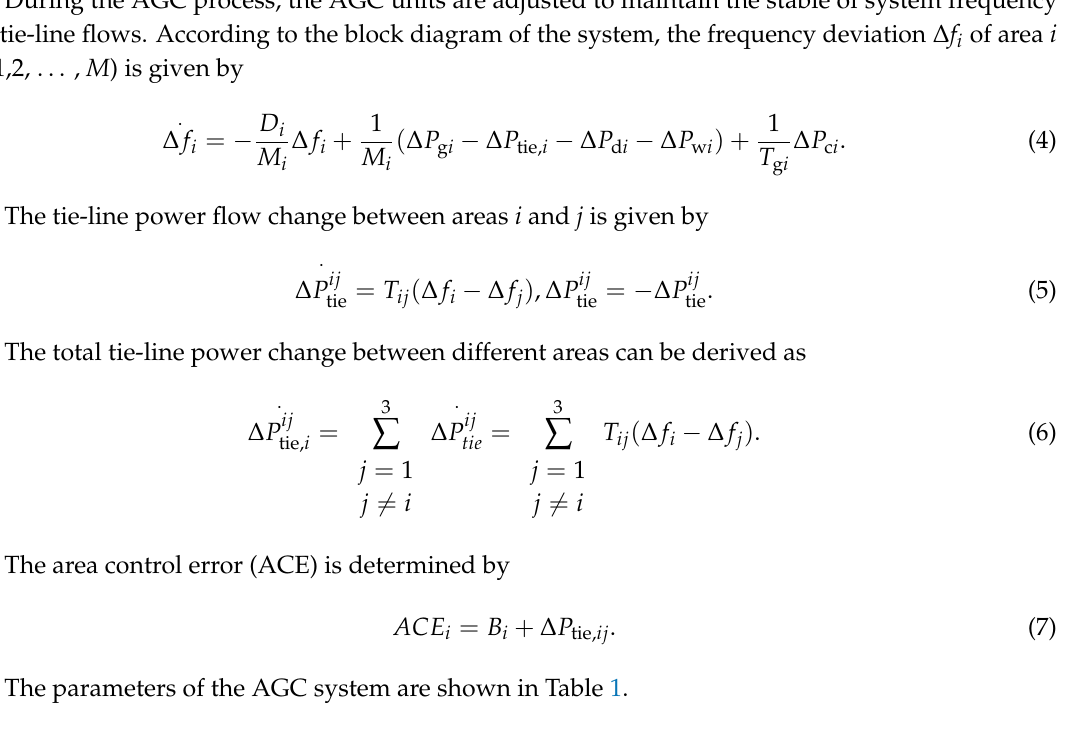
Table 1. Automatic generation control (AGC) system parameters description.